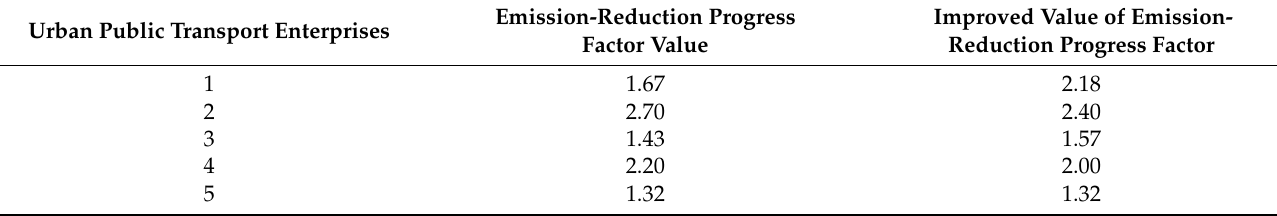
Table A2. Emission-reduction progress factor